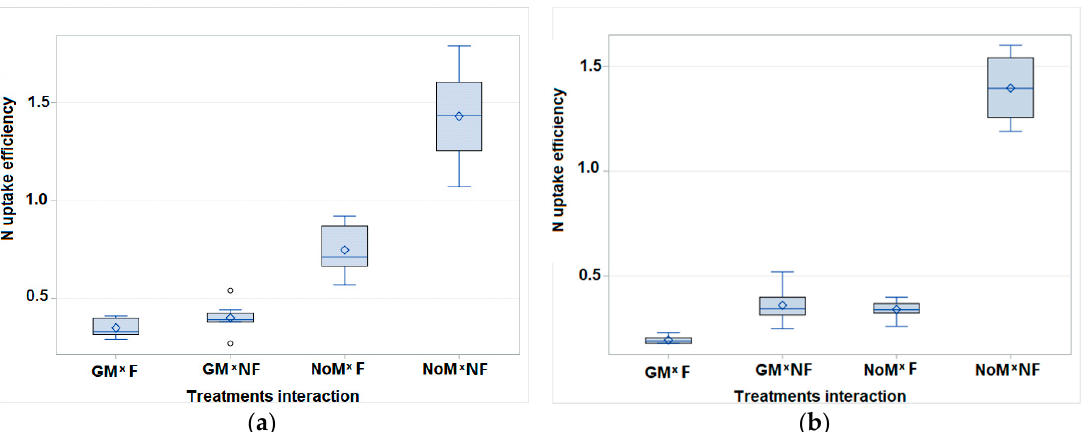
Figure 1. Box plots for the effect of the interaction between green manure and fertilization on the N uptake efficiency (total plant N to total N supply ratio; kg kg − 1 ) of the legume crops: ( a ) chickpea and ( b ) lentil (GM: green manure; NoM: no green manure; F: composted farmyard manure; NF: unfertilized control).